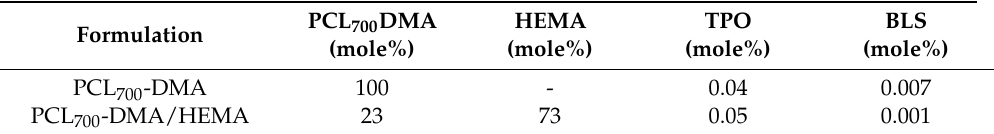
Table 2. Composition of resin formulations (PCL 700 -DMA) and (PCL 700 -DMA/HEMA) used to 3D print